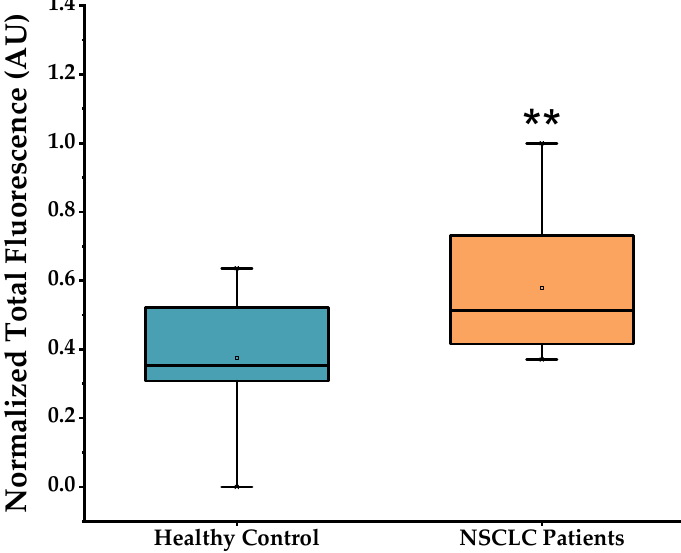
Figure 4. MB 21-5p hybridization assays with RNA from healthy control and NSCLC PBMCs (mean ± SD, ** p < 0.01). Data corrected for basal fluorescence and normalized to [0, 1]. Samples in study comprised: healthy control group ( n = 15); NSCLC group ( n = 24).